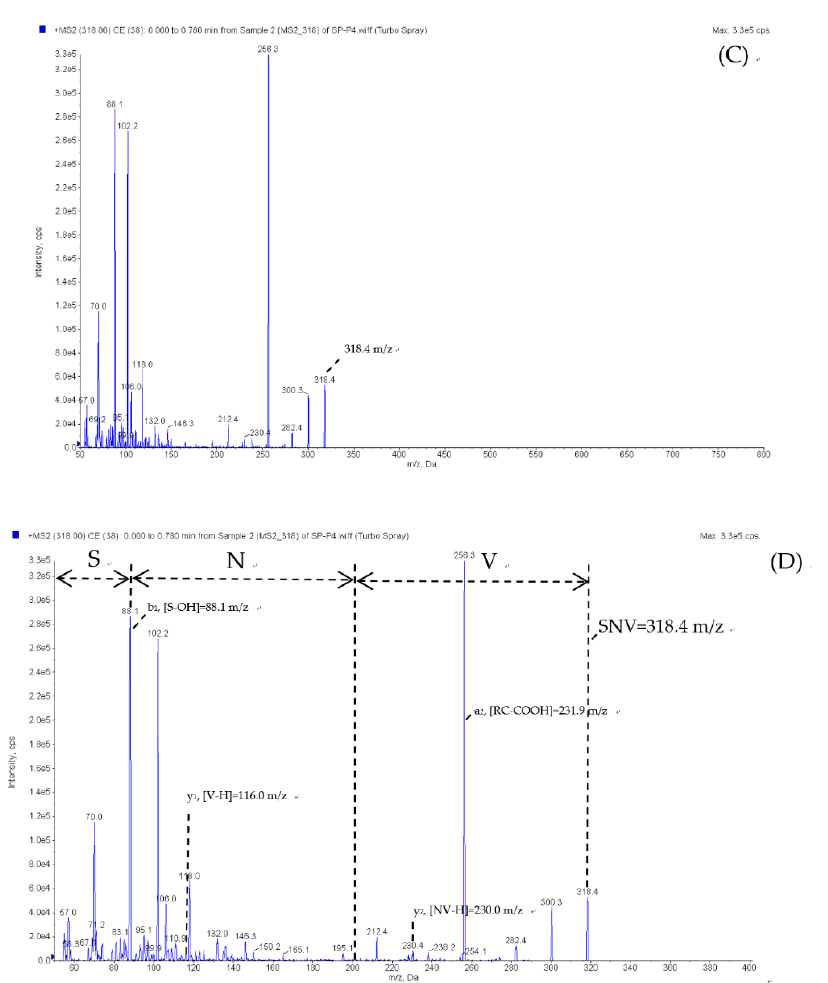
Figure A1. Identification of molecular mass and amino acid sequence of the peak D3 and D4 from HHP-FH-PR6 by ESI/MS/MS. ( A , B ) the MS/MS spectra of peptide RCD ( m / z 392.1). ( C , D ) the MS/MS spectra of peptide SNV ( m / z 318.4).